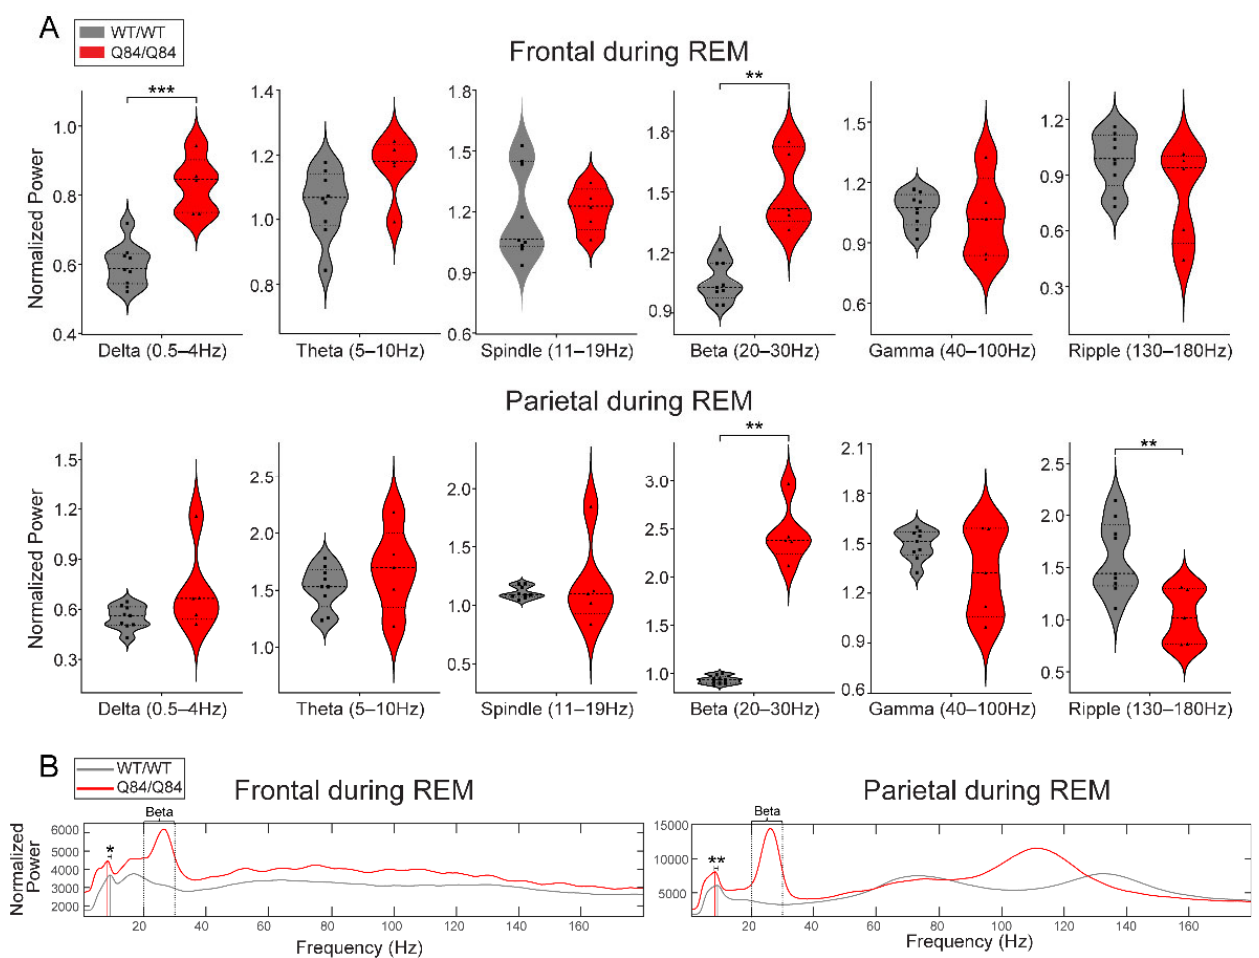
Figure 3. In REM sleep, homozygous Q84/Q84 mice show altered oscillatory power across many frequency bands, most clearly in frontal sites. ( A ) Homozygous Q84/Q84 mice (red, n = 5) show higher oscillatory power compared to the wild-type WT/WT (grey, n = 9littermates in the delta and beta frequency bands in frontal sites during REM. In parietal sites during REM, homozygous mice show higher beta and lower ripple activity than the wild-type mice. In violin plots, squares and triangles represent individual values for wild-type and homozygous mice, dashed lines display the median, and dotted lines show quartiles. ( B ) The total power averaged across all seconds of REM for each genotype plotted for better visualization. Homozygous mice show higher power across the low frequency bands including delta, theta, spindle, and beta bands spanning from 0.5–30 Hz in both frontal and parietal electrodes. Vertical grey and red lines indicate the peak theta frequency for wild-type and homozygous mice. In the frontal and parietal sites, theta peak is slower in the homozygous mice than in the wild-type mice. Frontal sites show higher power in all frequencies in fact, but parietal sites do not show overall changes in gamma power, rather only a frequency shift of a power bump from around 135 Hz to 110 Hz. All plots display results from the 12 h lights-on period (zeitgeber time (ZT) 0–12) and power is normalized by dividing over the respective frequency’s median value. Statistical difference only according to independent t -test or Mann–Whitney test. ** p < 0.01, *** p < 0.001. REM: rapid ‐ eye movement sleep.